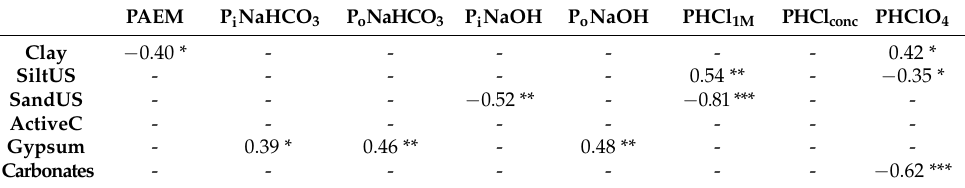
Table 4. Spearman’s correlations between P fractions and soil composition parameters (“-” means not significant). Significance: *** p < 0.001, ** p < 0.01, * p <